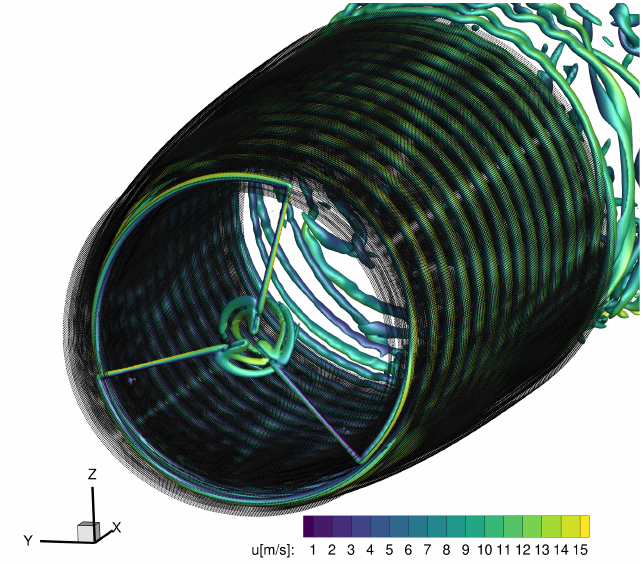
Figure 5. Grid refinement area around the blade tip vortex helix